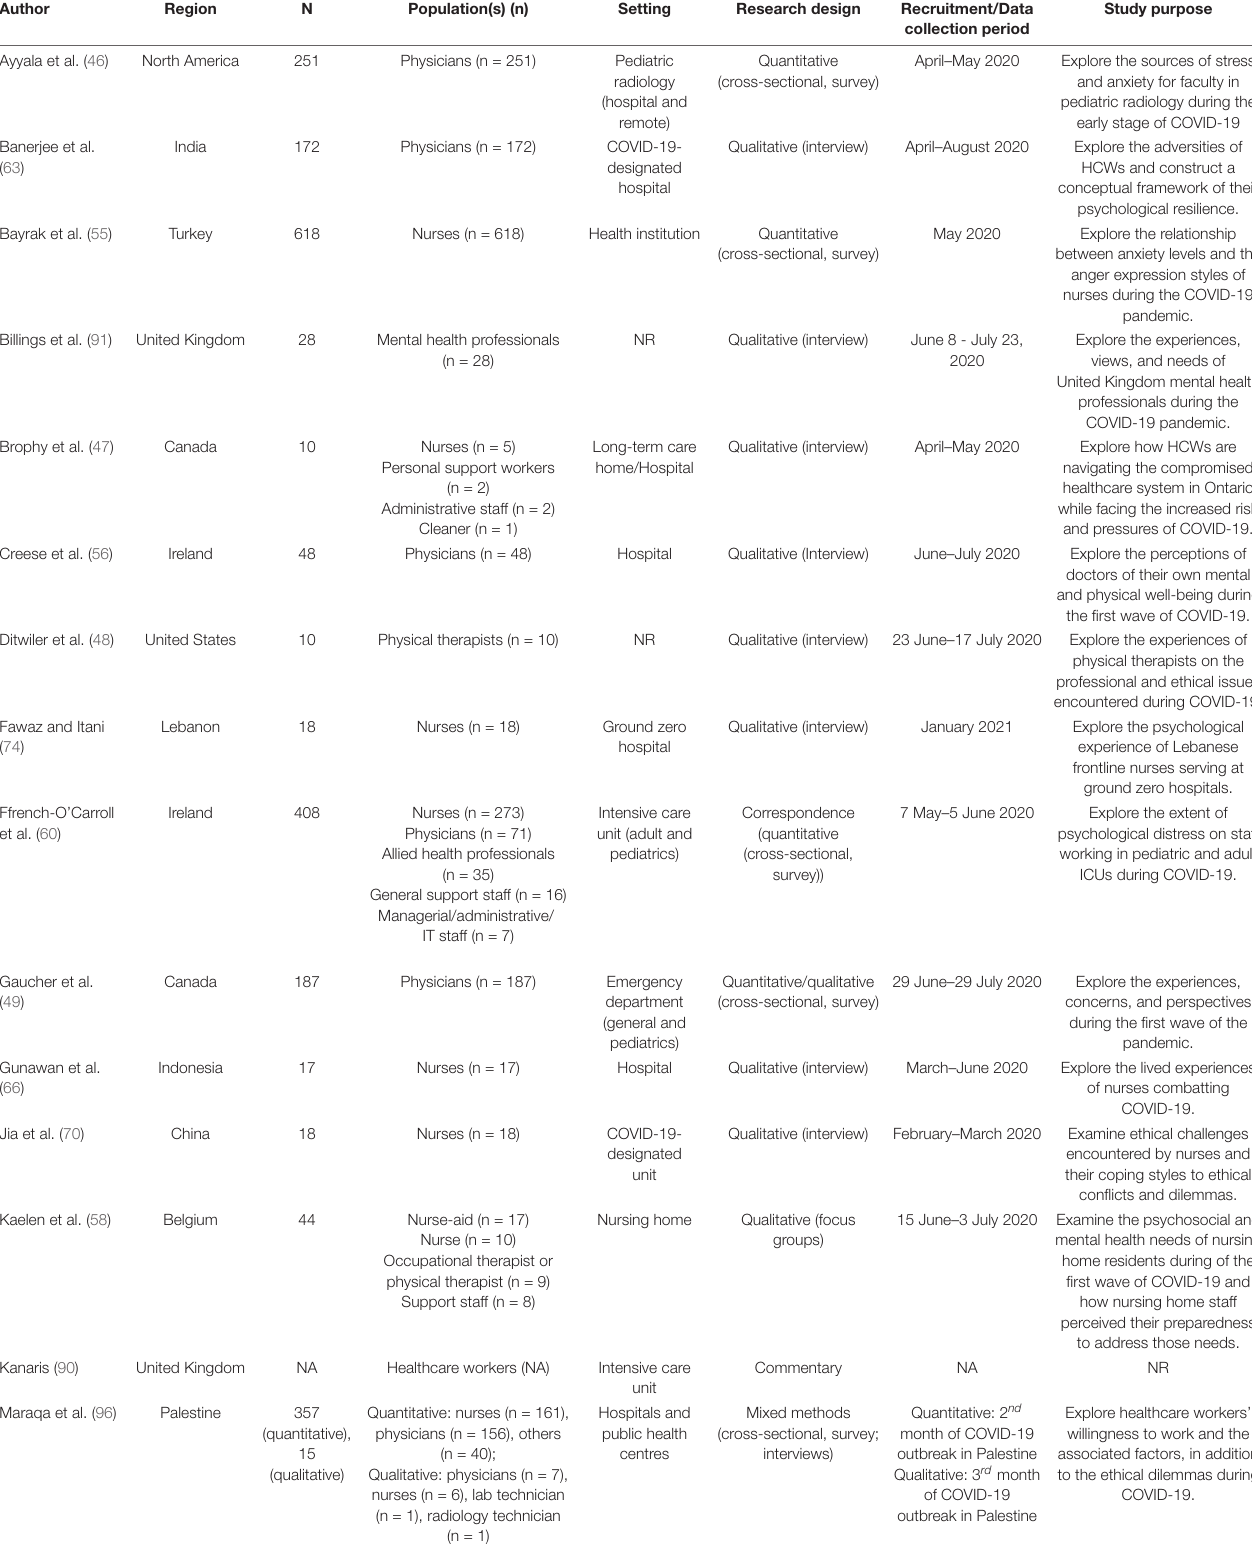
TABLE 1 | Study characteristics of included